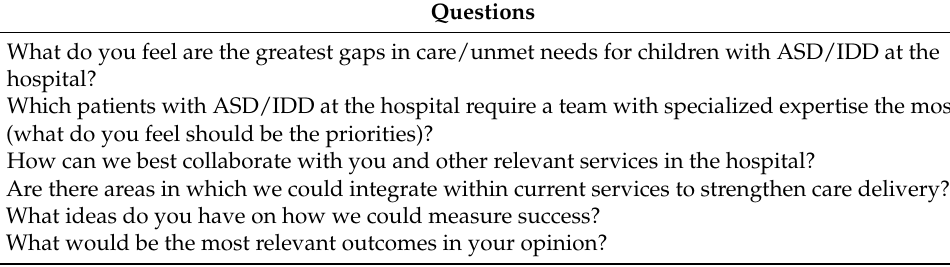
Table 1. Stakeholder engagement discussion